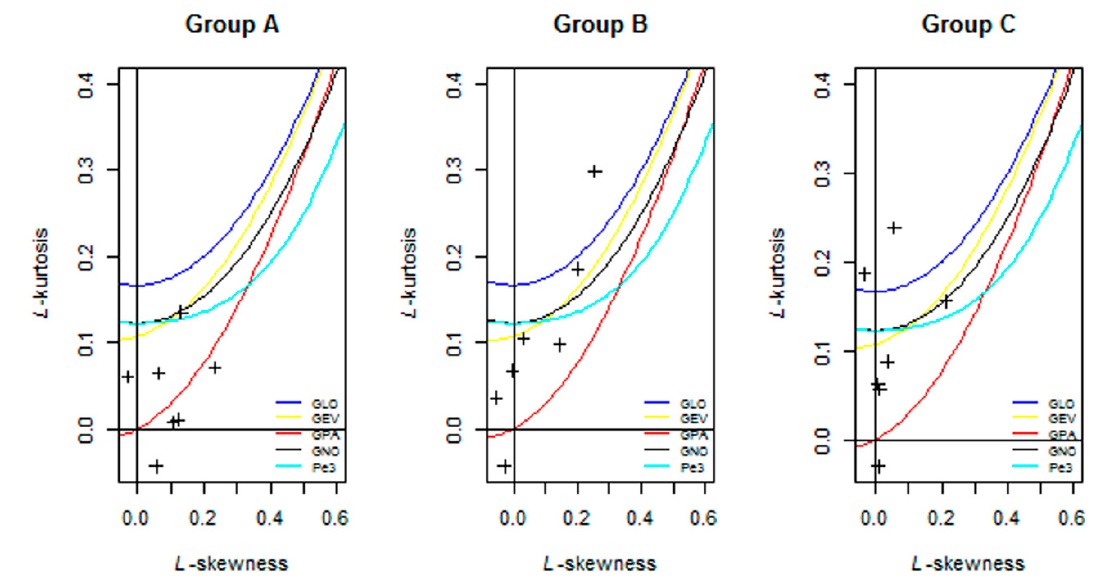
Figure 5. L-moment ratio diagrams for the homogeneous groups. GLO: generalized logistic distribution; GEV: generalized extreme value distribution; GPA: generalized Pareto distribution; GNO: generalized normal distribution; PE3: Pearson Type III distribution. Table 6. Z-statistic values of the homogeneous groups.